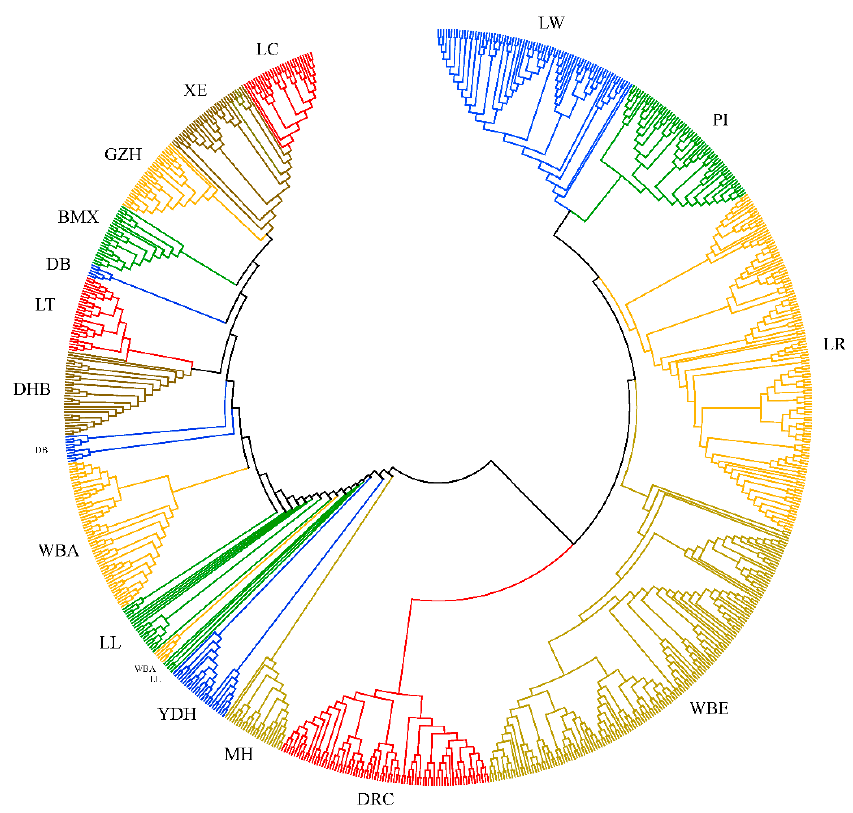
Figure 1. The neighbor-joining tree of the tested populations 1 . 1 DR = Duroc, LW = Large White, LR = Landrace, PI = Pietrain, WBE = European wild boar, WBA = Asian wild boar, BMX = Bamaxiang, DB = Debao, DHB = Dahuabai, GZH = Guizhonghua, LC = Luchuan, LL = Longlin, LT = Lantang, MH = Meihua, XE = Guangdongxiaohua, YDH = Yuedonghei.